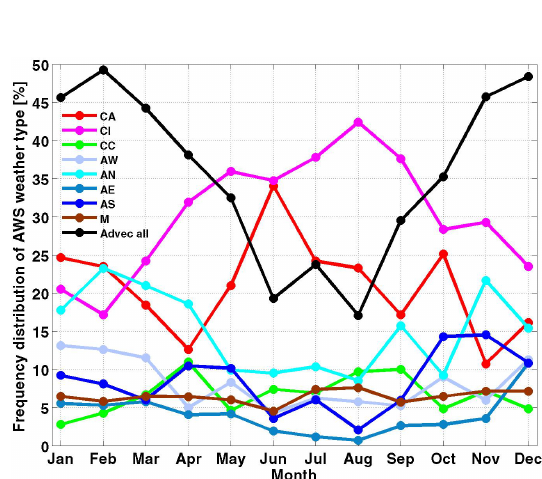
Fig. 2. Monthly frequency distribution of SYNALP weather types for the 1995–2008